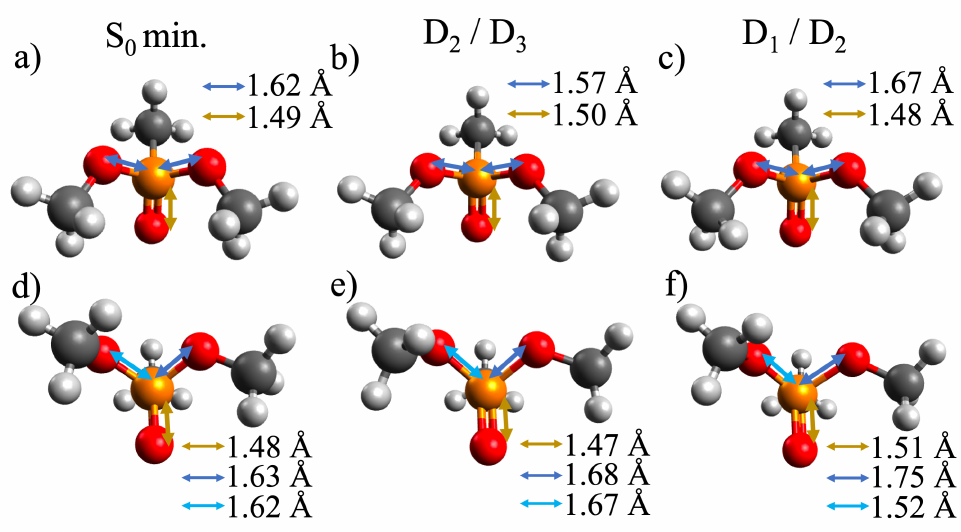
Figure 6. Structures of ( a , d ) S 0,C and S 0,C geometries, and the conical intersections between s 1 ( b , e ) D 2 /D 3 and ( c , f ) D 1 /D 2 states for the ( b , c ) C s symmetric and ( e , f ) C 1 asymmetric conform- ers. CoIns structures are optimized at the CASSCF level. The three P-O bond lengths are shown in